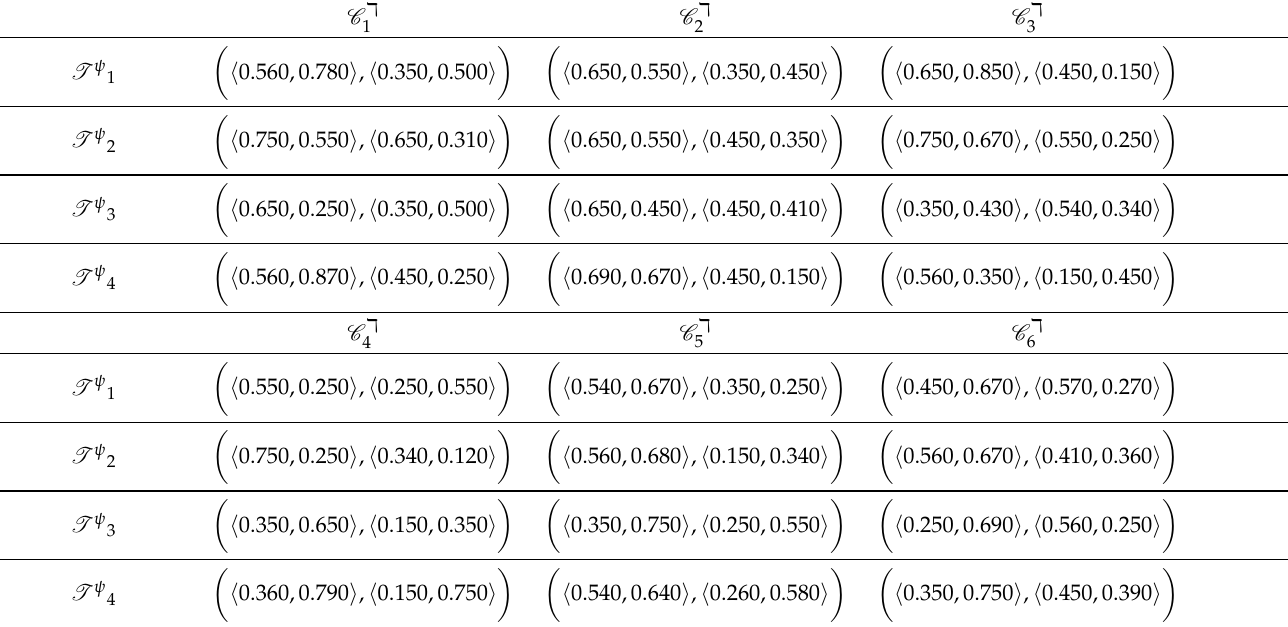
Table 7. Assessment matrix acquired from O G 3